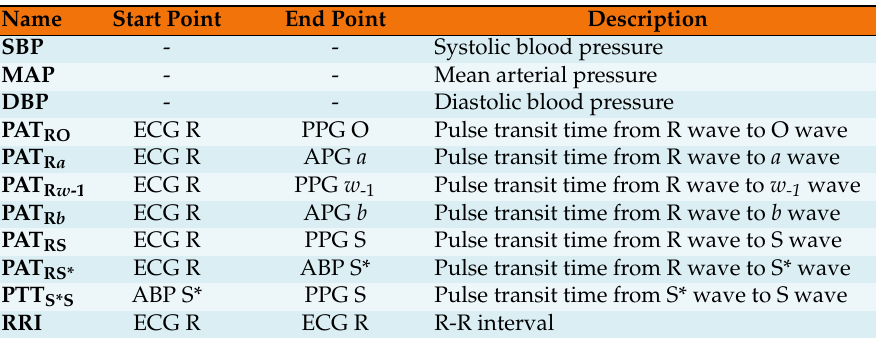
Table 2. Artery wave propagation feature